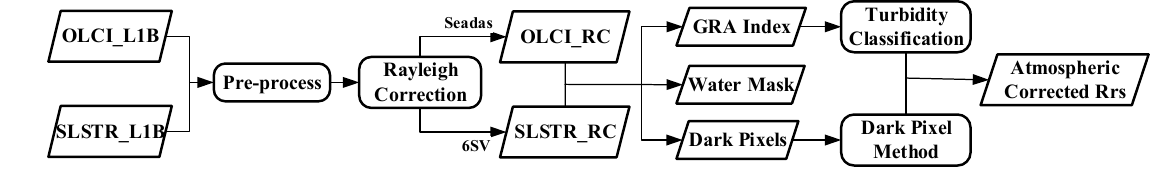
Figure 3. The processing procedure of the ACbTC algorithm.